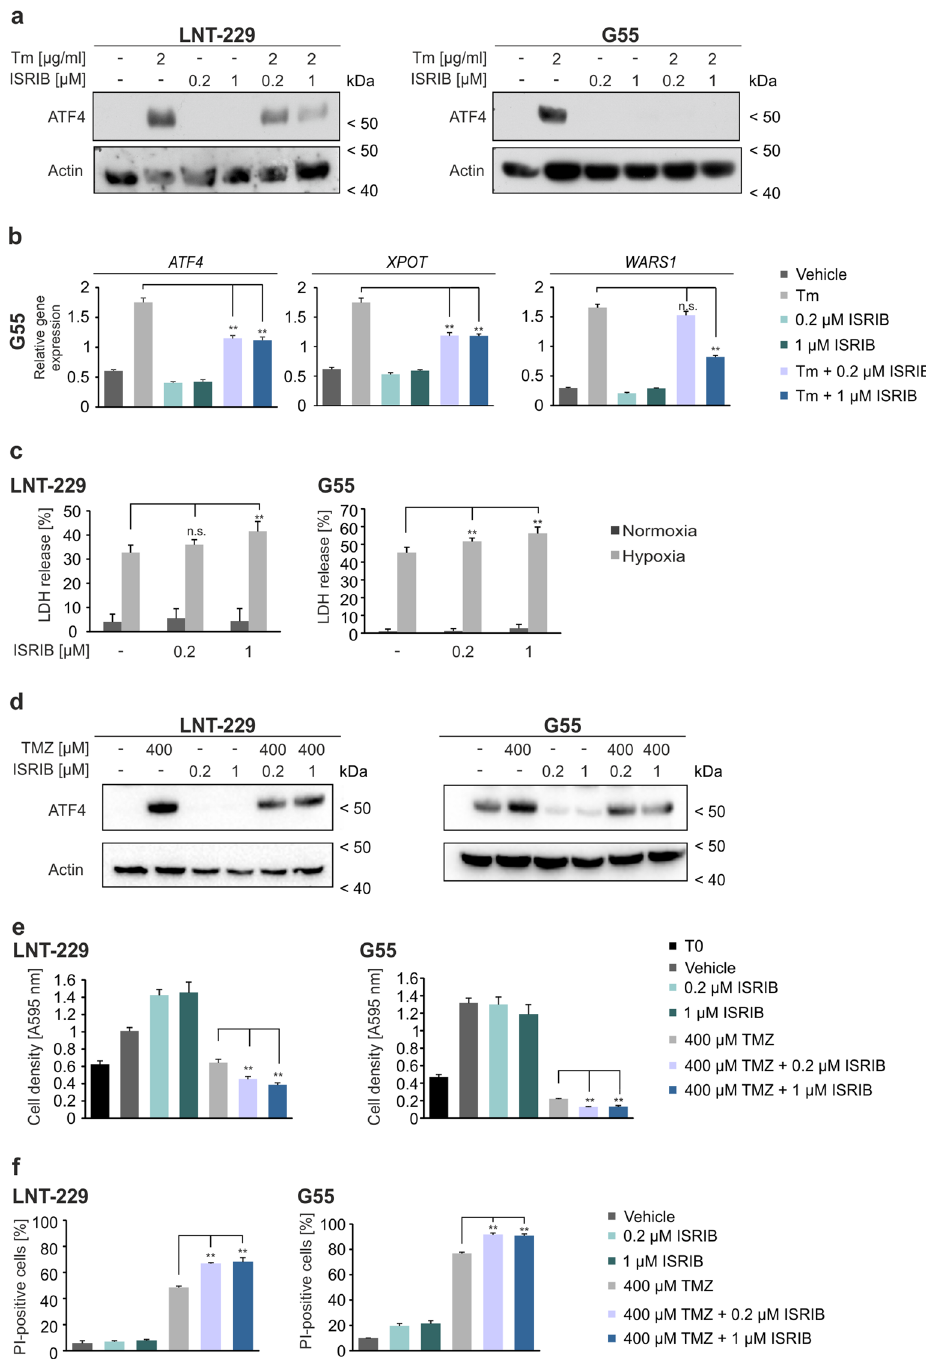
Figure 4. ISRIB treatment sensitizes human GB cells to hypoxia induced cell death and increases temozolomide toxicity. ( a ) LNT-229 and G55 cells were treated with 2 µg/ml tunicamycin (Tm), 0.2 µM or 1 µM ISRIB or a combination of both substances in serum-free DMEM for 8 h as indicated. Cellular lysates were analyzed by immunoblot with antibodies for ATF4 and actin. ( b ) Isolated cDNA of G55 cells was analyzed by qPCR for the expression of ATF4 , XPOT and WARS1 . SDHA and 18S were used for normalization (n = 3, mean ± SD, n.s. not significant, **p < 0.01, Student’s t-test). ( c ) LNT-229 and G55 cells were incubated in serum-free DMEM without glutamine in normoxia or hypoxia (0.1% O 2 ). Cell death was analyzed by LDH release assay (n = 4, mean ± SD, n.s. not significant, **p < 0.01, Student’s t-test). ( d ) Cellular lysates of LNT-229 and G55 cells treated with temozolomide and ISRIB for 24 h in serum-free DMEM as indicated were analyzed by immunoblot with antibodies for ATF4 and actin. ( e ) LNT-229 and G55 cells were treated for 72 h in serum-free DMEM as indicated. Cell densities were measured by CV staining (n = 3, mean ± SD, **p < 0.01, Student’s t-test). ( f ) Cell death of LNT-229 and G55 cells was analyzed by propidium iodide (PI) uptake and quantified by flow cytometry (n = 3, mean ± SD, **p < 0.01, Student’s t-test) after treatment with temozolomide and ISRIB in serum-free DMEM for 72 h as indicated. Data analysis was performed with BD FACS Diva software (version